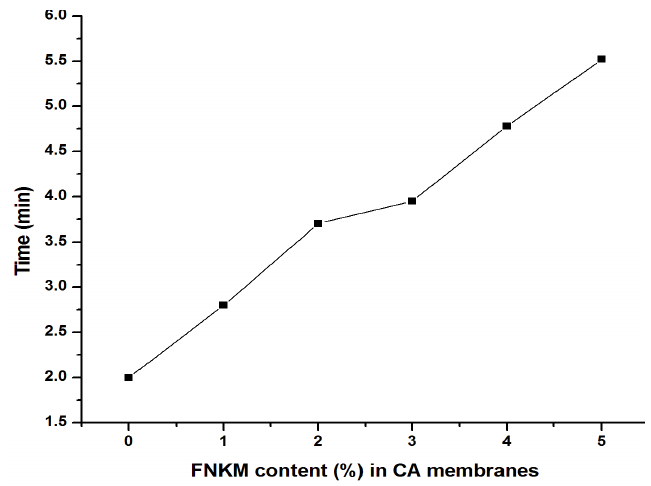
Figure 10. Correlation between FNKM loading content and time taken to collect 100mL permeate.